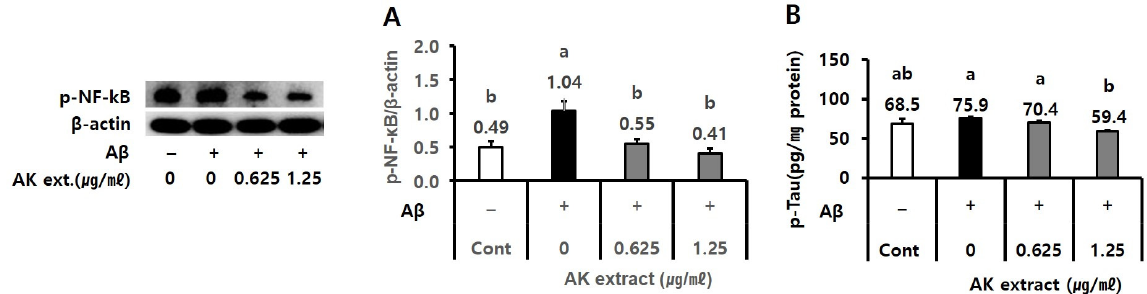
Figure 3. Effect of AK extract on the expression of ( A ) p-NF- κ B, and ( B ) p-tau production in A β - treated SH-SY5Y cells. SH-SY5Y cells (1 × 10 5 cells/mL) were treated with sample extracts for 2 h, and serum-free medium was used as the control. The plate was treated with 0.1 or 0.3 µM A β for 21–48 h. (–), A β -untreated experiment; (+), A β -treated experiment; A β , amyloid 1–42 ; Cont, control ( n = 2 for p-NF- κ B and p-tau production). Statistical analysis was performed using SAS software. The values marked by different letters in A and B were found to differ significantly at p < 0.05 by Duncan’s multiple range test.